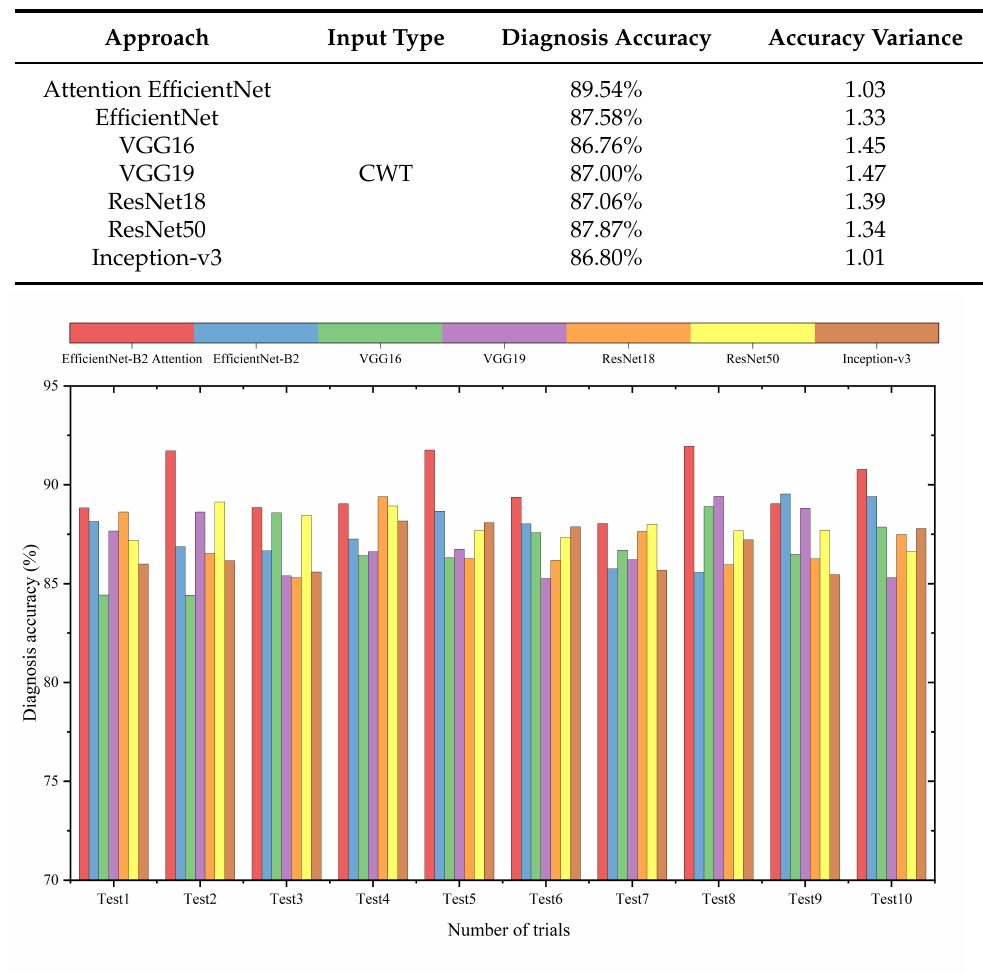
Table 4. Performance of different comparison methods.